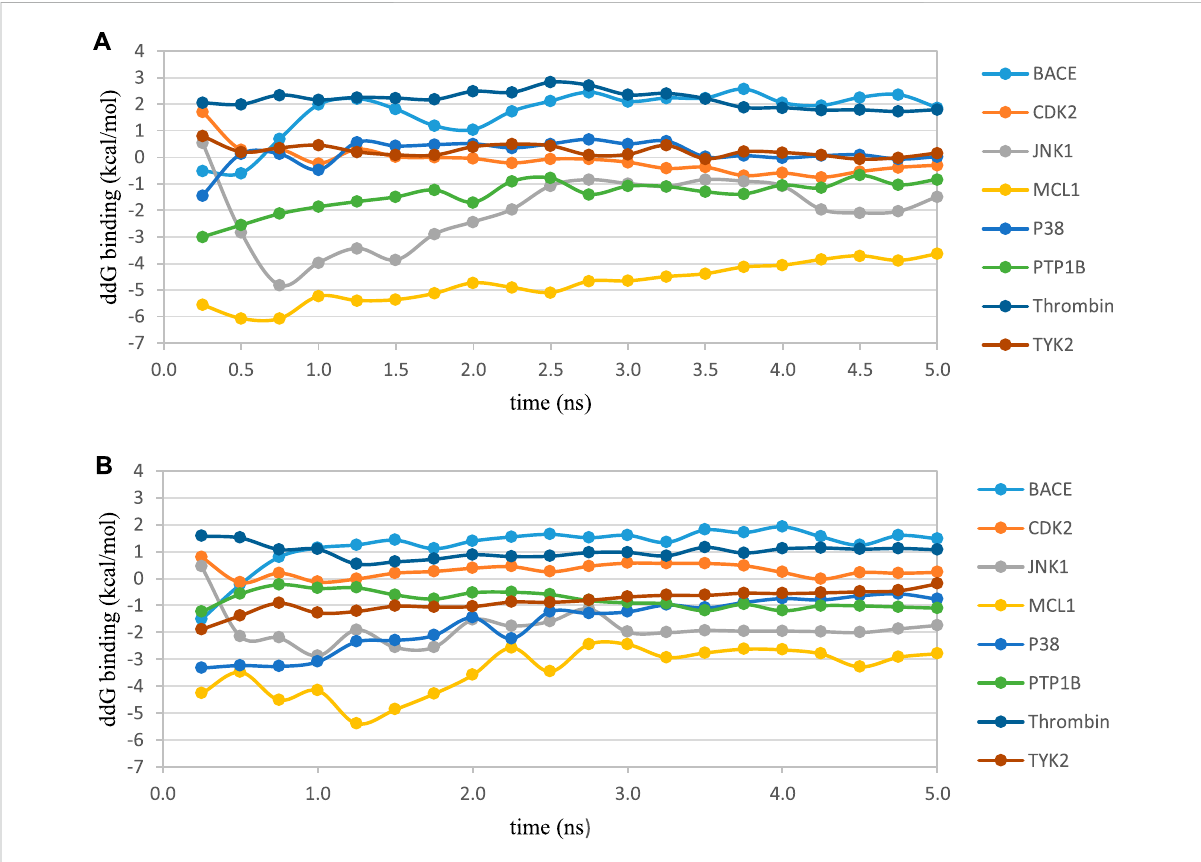
FIGURE 1 Convergence of the RBFE for the representative perturbation in each test case using the AMBER ff14SB force fi eld with AM1-BCC charges and (A) SPC/Ewatermodelor (B) TIP3Pwatermodel.Ineachtestcase,theperturbationwiththelowestsimilarityscore(Liuetal.,2013)obtainedfromthe Schrödinger FEP+ panel was chosen as the representative perturbation in this plot. Free energies were estimated every 0.25